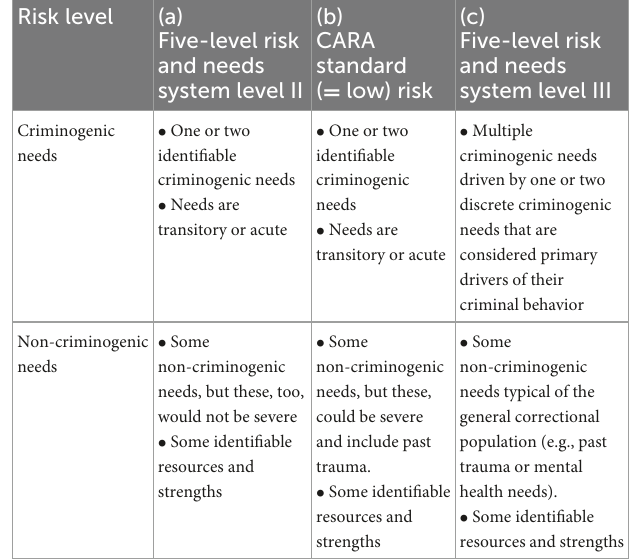
TABLE 15 Analysis of